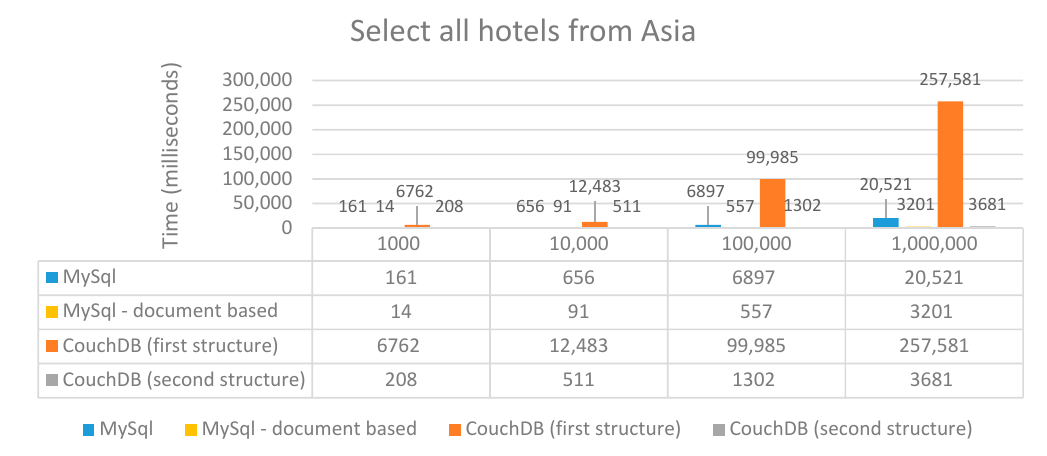
Table 8. Complex select with four inner join operations.